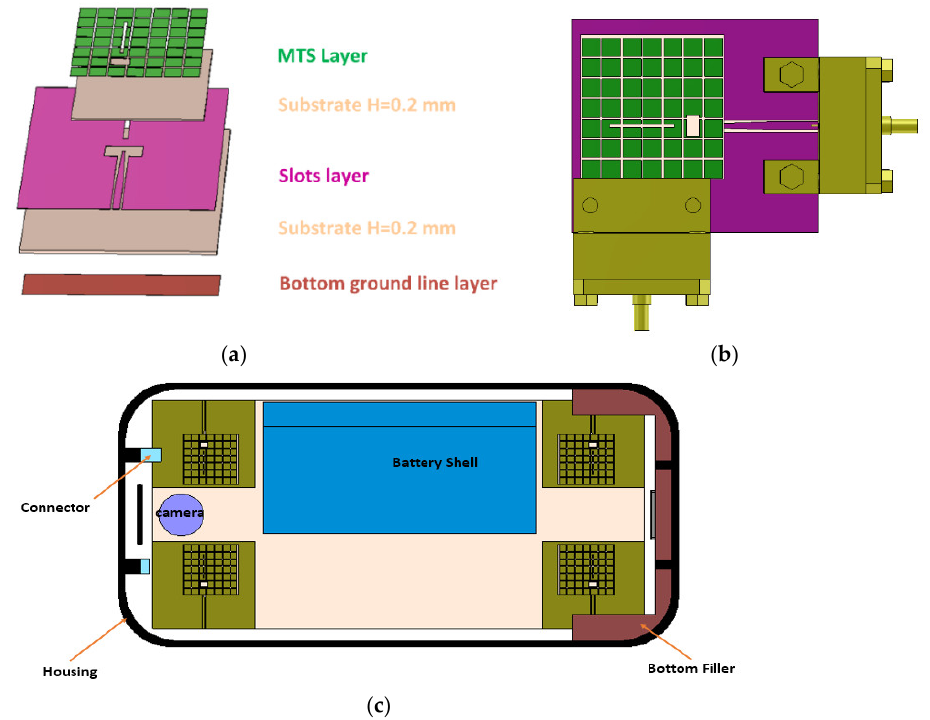
Figure 10. Configuration of the MIMO antenna with the MTS [30]; ( a ) 3D structure, ( b ) top view, and ( c ) view of the antenna inside mobile housing.